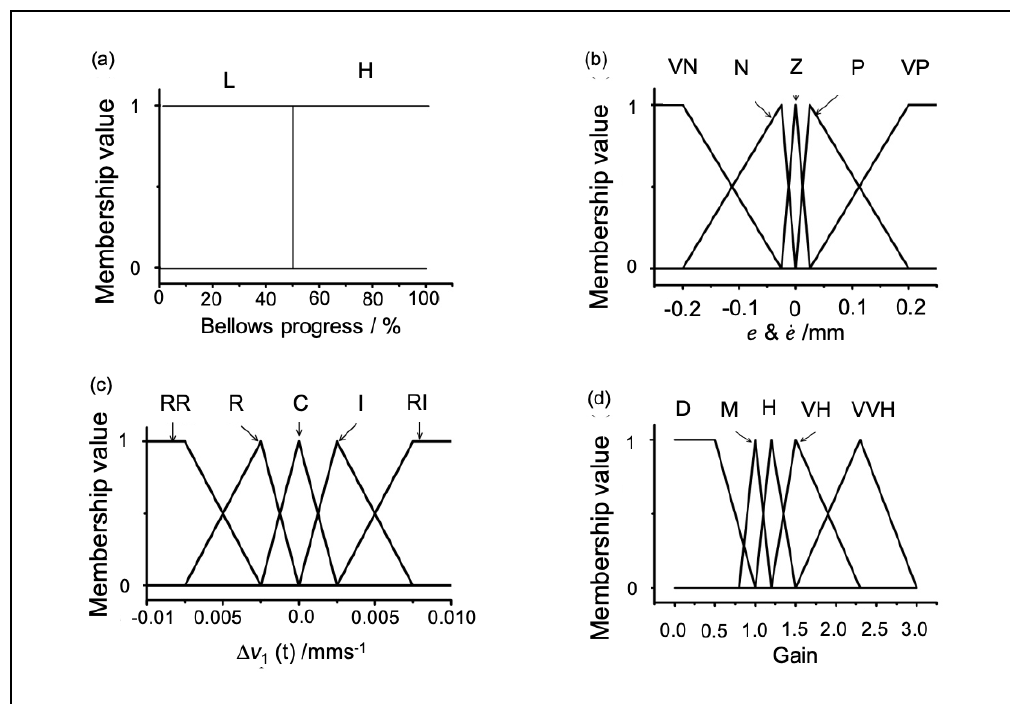
Figure 12. Membership functions of conventional fuzzy controller: ( a ) bellows formation progress consist of two membership function L (Low), H (High), ( b ) bellows height error and changing rate of the error has similar membership function VN (Very Negative), N ( Negative), Z (Zero), P (Positive), VP (Very Positive), ( c ) incremental compression speed ( ∆ v 1 ) consist of membership function RR (Rapid Reduce ), R (Reduce), C (constant), I (Increase), RI (Rapid Increase), and ( d ) gain consist of membership function D (Decrease), M (Medium), H (High), VH (Very High), and VVH (Very Very High). Table 2. Conventional fuzzy rules to determine the compression speed adjustment v 1 . (*Refer to Figure 12).